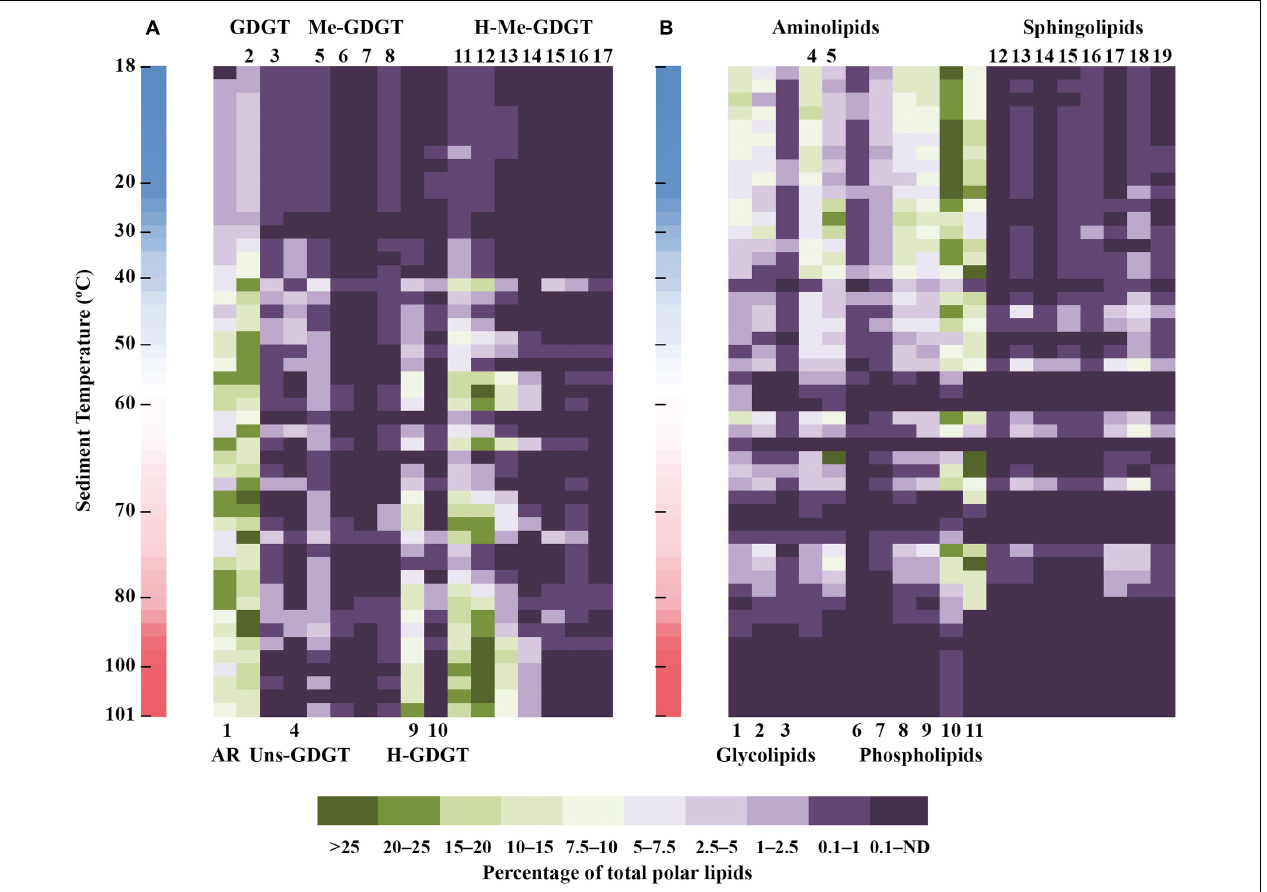
FIGURE 4 | Heat map distribution of archaeal (A) and non-archaeal (B) polar lipid classes in sediments of Spathi Bay. Green to dark purple scale (in %) refers to the contribution of lipid classes relative to the total polar lipid concentration. ND, not detectable. Adjacent vertical bars indicate the thermal gradient in sediments ranging from 18 to 101 ◦ C. List of compounds in A (archaeal lipids): 1 (G-AR), 2 (G-GDGT), 3 (2G-GDGT), 4 (G-Uns-GDGT), 5 (G-Me-GDGT), 6 (G-2Me-GDGT), 7 (2G-Me-GDGT), 8 (2G-2Me-GDGT), 9 (G-H-GDGT), 10 (2G-H-GDGT), 11 (G-H-1Me-GDGT), 12 (G-H-2Me-GDGT), 13 (G-H-3Me-GDGT), 14 (G-H-4Me-GDGT), 15 (2G-H-1Me-GDGT), 16 (2G-H-2Me-GDGT), 17 (2G-H-3Me-GDGT). List of compounds in B (non-archaeal lipids): 1 (G), 2 (SQ), 3 (2G), 4 (BL), 5 (OL), 6 (PDME), 7 (PME), 8 (PE), 9 (PG), 10 (PC), 11 (CL), 12 (sPA), 13 (sP-Uk1), 14 (sP-Uk2), 15 (sP-Uk3), 16 (sP-Uk4), 17 (sPI), 18 (sPE), 19 (sPG). sP-Uk1–4: unknown glycosylated phosphatidyl sphingolipids (see Supplementary Figure S3 for structure